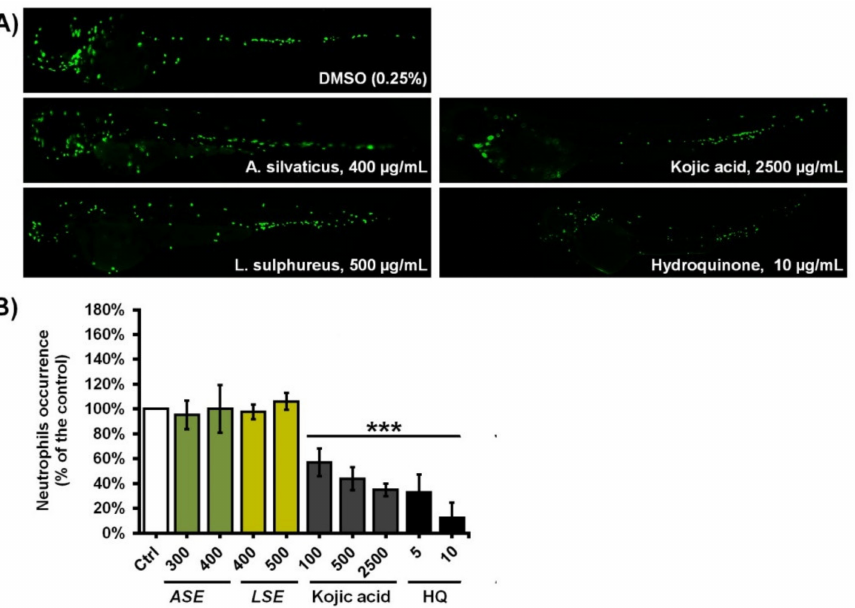
Figure 4. Depigmenting extracts ASE and LSE do not induce inflammation or neutropenia upon anti-melanogenic doses. ( A ) Morphology of Tg ( mpx :GFP)i114 embryos exposed to various doses